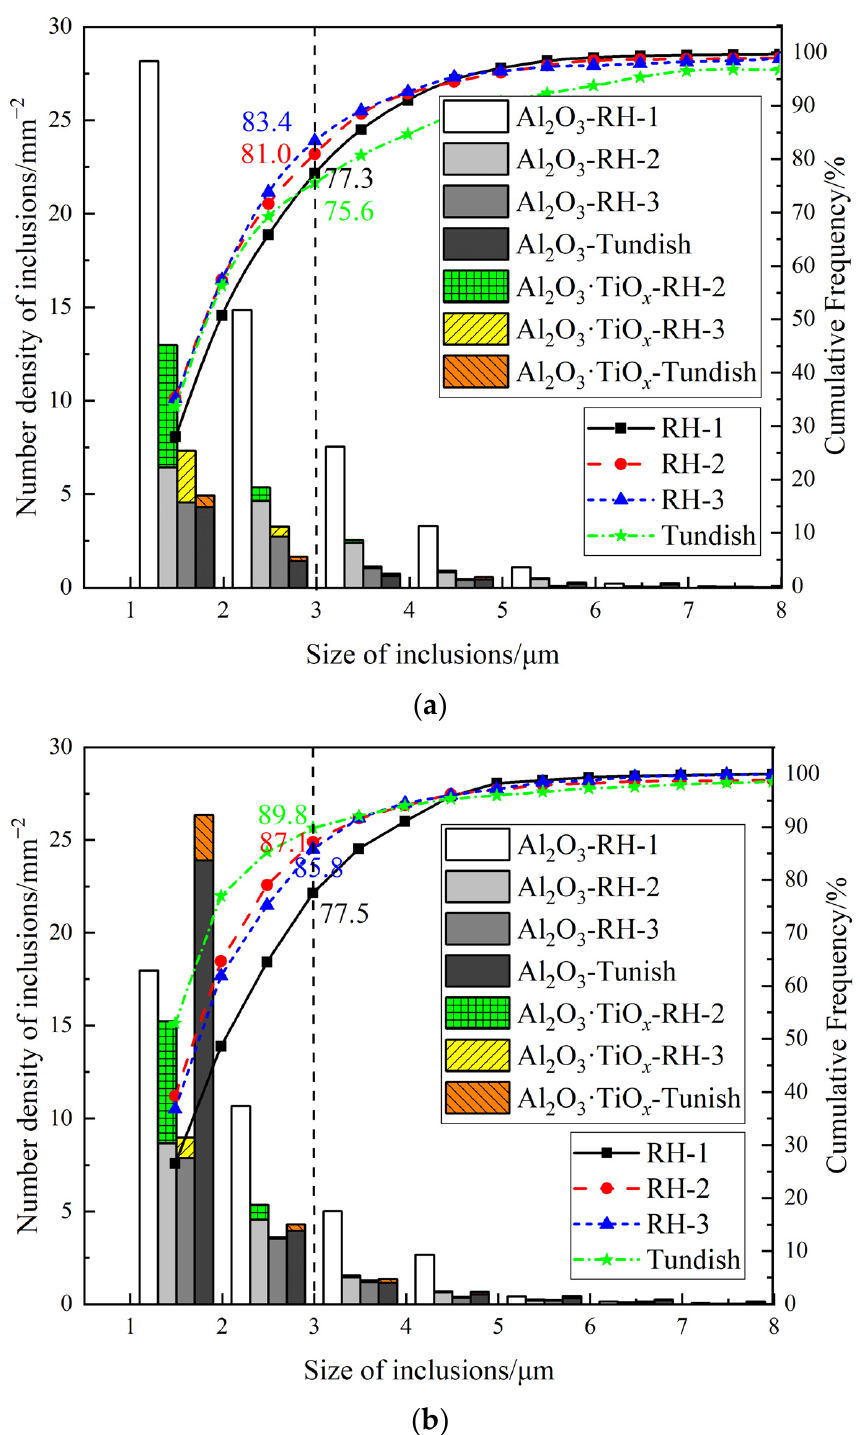
Figure 5. Size distribution of inclusions in ( a ) Heat 1 and ( b ) Heat 2 during RH treatment and tundish processes.